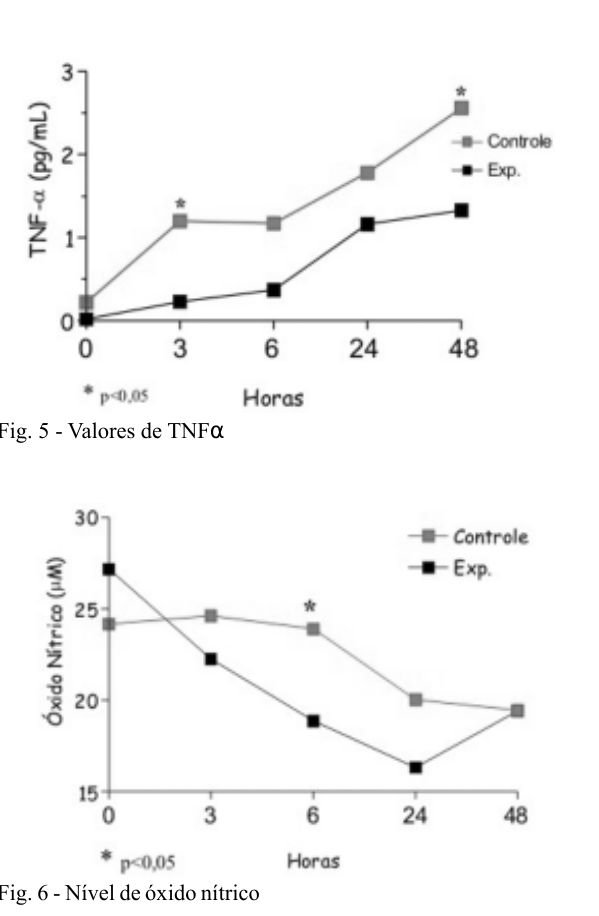
Fig. 6 - Nível de óxido nítrico